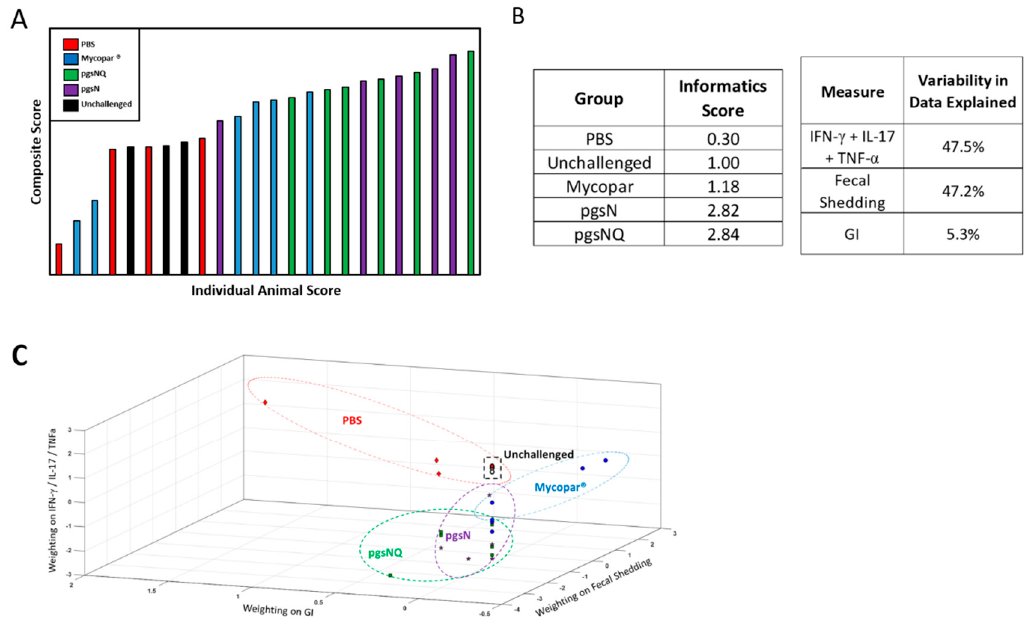
Figure 7. Composite analysis of the efficacy of live and inactivated vaccine candidates. ( A ) Ranked animal scores of the composite analysis based on fecal shedding, histological lesions and cytokine levels using principal component analysis (PCA). ( B ) Group scores with percentage of variability among animal groups using PCA. ( C ) A 3D mapping of calves of individual composite scores based on the readout measures used in the study (cytokine levels, lesion scores and fecal shedding). Note the close proximity of profiles generated by the pgsN and pgsNQ groups compared to Mycopar, unchallenged and infected groups. Each point in ( C ) represents an individual animal.